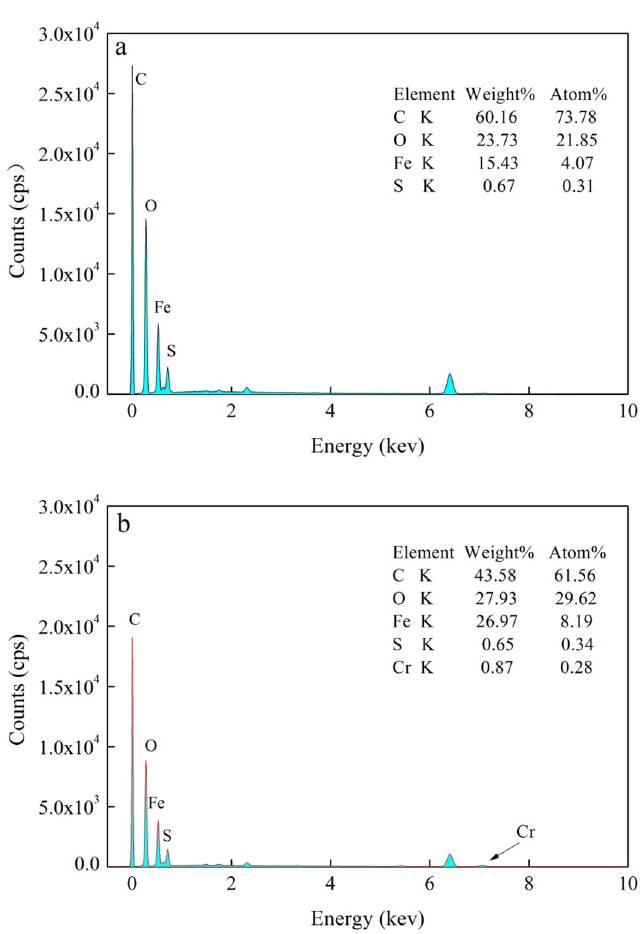
Figure 5. Energy spectrum analysis before adsorption ( a ) and after adsorption ( b